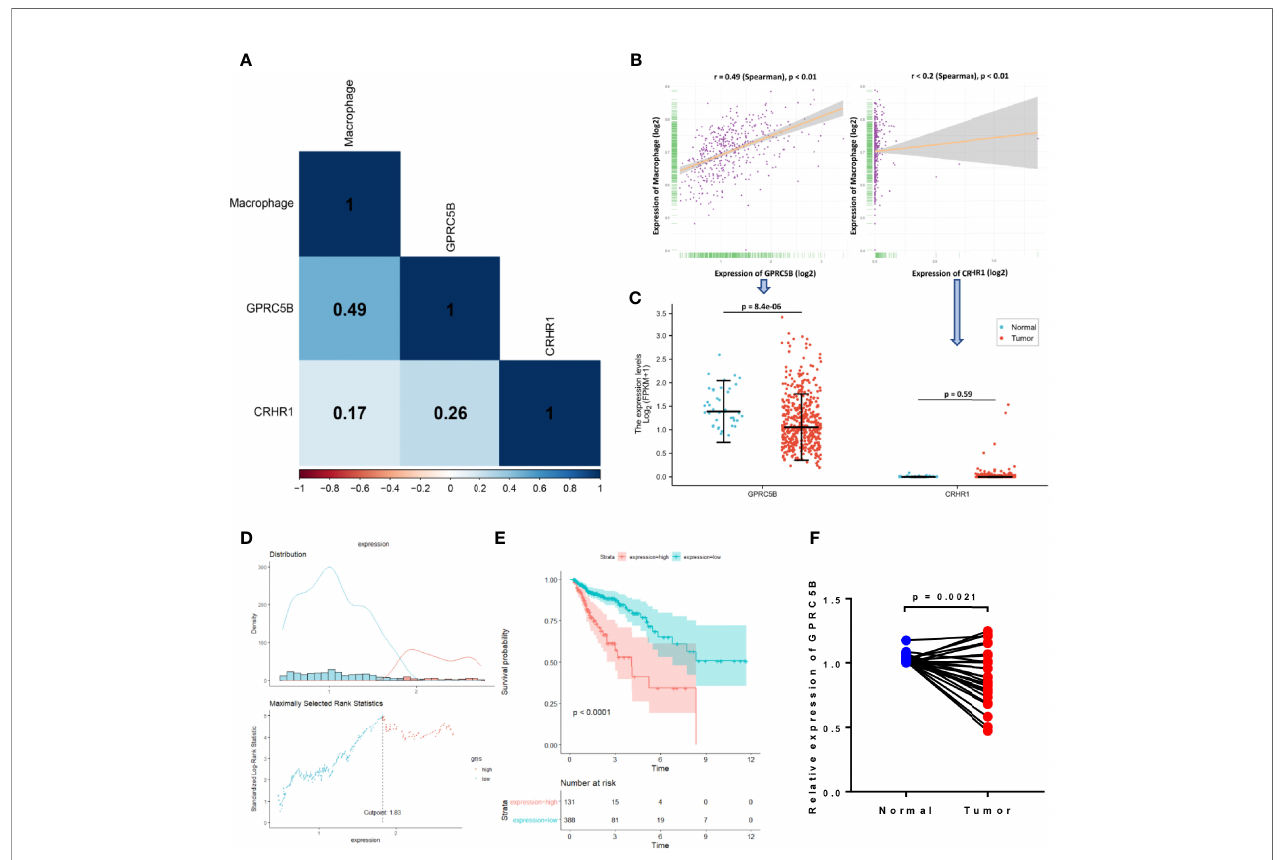
FIGURE 4 | (A) Correlation heatmap of macrophages and CRHR1 and GPRC5B expression. (B) GPRC5B was signi fi cantly correlated with macrophages (r = 0.49, Spearman, p < 0.01). CRHR1 was statistically, but weakly, correlated with macrophages (r < 0.2, Spearman, p < 0.01). (C) GPRC5B was a differentially expressed gene in COAD samples (p = 8.4e-06), whereas CRHR1 was only detected in a small number of samples. (D) An illustration of the optimal cutoff point identi fi cation for survival analysis in (E) . (E) GPRC5B was a potential prognostic risk factor in COAD patients (p < 0.0001). (F) For qPCR validation, clinical samples of 28 COAD tissues and paired normal tissues were acquired from Tongji Hospital, Shanghai, China. GPRC5B was signi fi cantly downregulated in COAD tissues (p = 0.0021). CRHR1, corticotropin releasing hormone receptor 1; GPRC5B, G protein-coupled receptor class C group 5 member B; COAD, colon